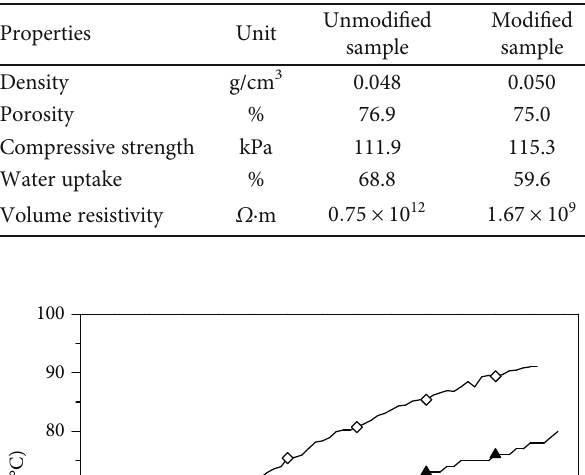
Table 2: The properties of PU nanocomposites using 3wt.% MWCNTs with and without modi fi cation.